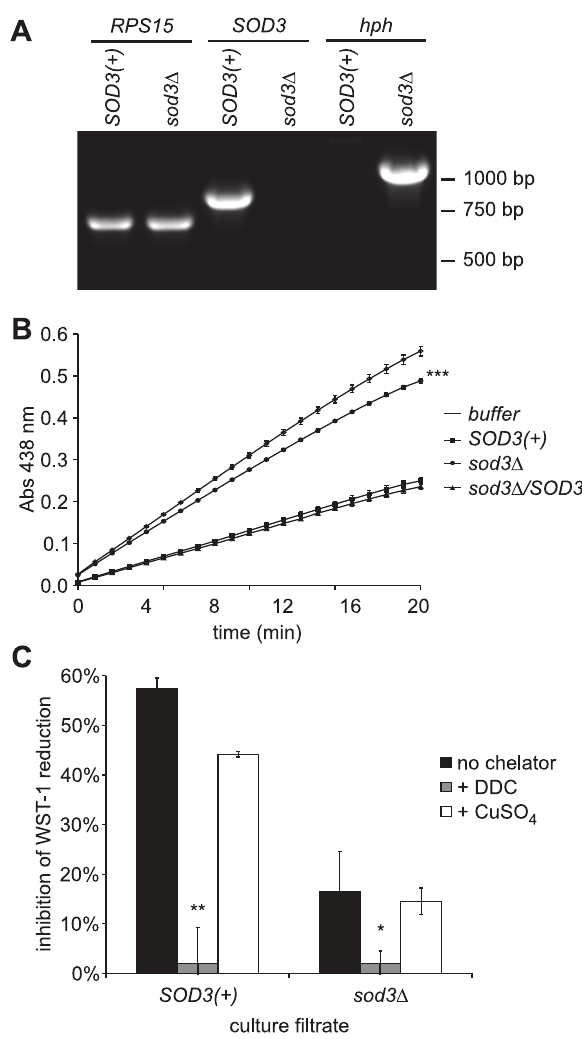
Figure 1. Histoplasma Sod3 encodes an extracellular Cu ++ - dependent superoxide dismutase. ( A ) PCR validation of deletion of the SOD3 gene. Genomic DNA from the SOD3( + ) parental strain (WU8) and the sod3 D strain (OSU13) were tested by PCR for the ribosomal subunit gene RPS15 , the wild-type SOD3 gene, and the mutant allele marked with the hygromycin resistance gene ( hph ). ( B ) Superoxide dismutase activity in culture filtrates harvested from SOD3( + ) (OSU45), sod3 D (OSU15), and the sod3 D /SOD3 complemented (OSU49) strains. Detection of superoxide was determined through superoxide-depen- dent reduction of the WST-1 tetrazolium dye after generation of superoxide using hypoxanthine and xanthine oxidase. Reduction of WST-1 was monitored by absorbance at 438 nm. Buffer or culture filtrates contained 5 m g ovalbumin or total culture filtrate protein, respectively. Asterisks represent significant difference (*** p , 0.001) in the inhibition of WST-1 reduction between SOD3( + ) and sod3 D culture filtrates. Data shown is representative of three independent exper- iments, each performed with triplicate samples. ( C ) Sod3 activity following Cu ++ depletion. Culture filtrates containing 5 m g total protein from SOD3( + ) (OSU45) and sod3 D (OSU15) strains were tested for their ability to inhibit WST-1 reduction by superoxide before (no chelator), after Cu ++ depletion ( + DDC), and after subsequent repletion with 50 mM Cu ++ ( + CuSO 4 ). Values represent relative inhibition of WST-1 reduction by culture filtrate samples (n=3) compared to buffer controls treated in parallel. Asterisks represent significant differences from SOD3( + ) culture filtrates (* p , 0.05, ** p , 0.01).